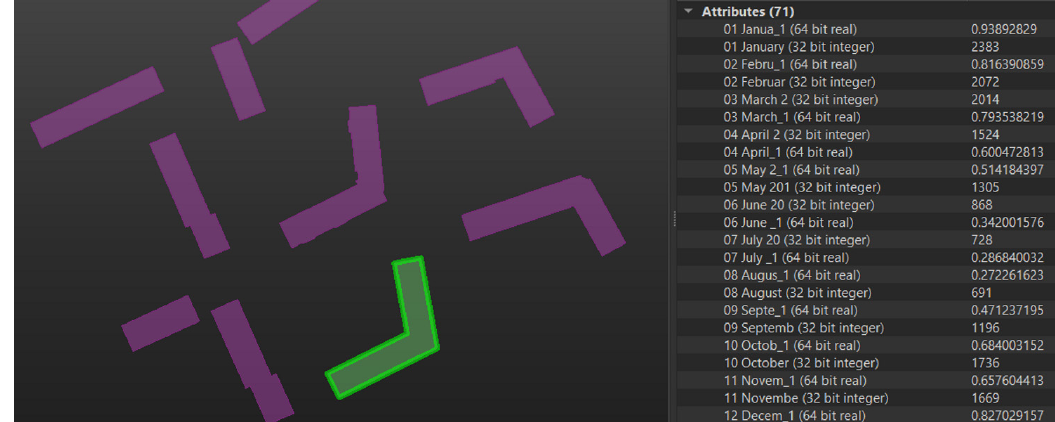
Figure 12. This study’s building footprints with energy use information.